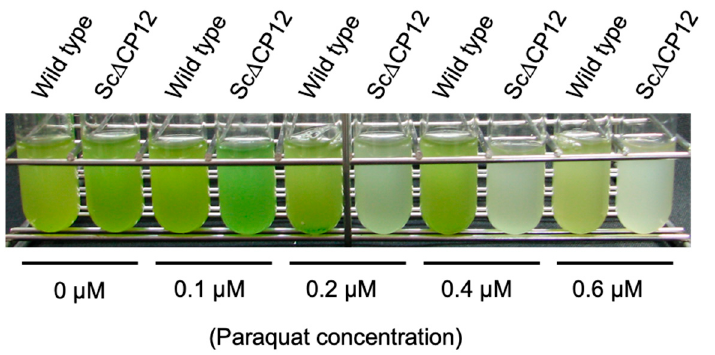
Figure 5. Effect of paraquat treatment on the growth of wild-type and Sc ∆ CP12 mutant S. 7942 cells. Wild-type and Sc ∆ CP12 mutant S. 7942 cells were cultured in 10 mL of Allen’s medium containing various concentrations of paraquat on a rotary shaker (120 rpm) under continuous light (40 μ mol photons m − 2 s − 1 ) at 27 °C.